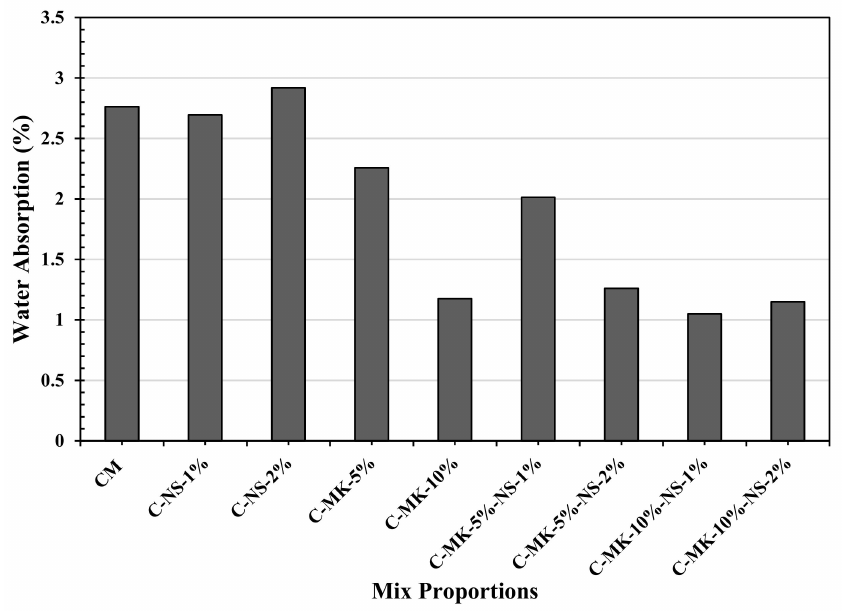
Figure 3. E ff ects of the combination of MK and NS on the water absorption capacity of